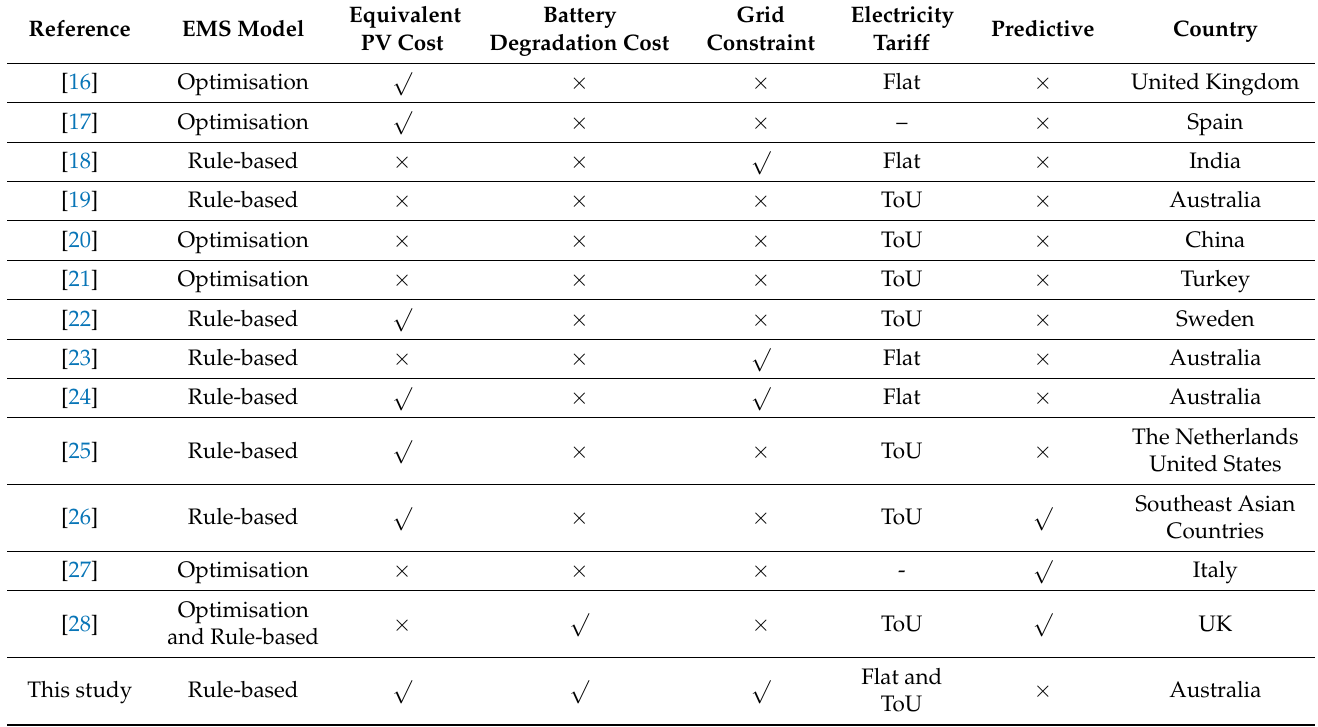
Table 1. Summary of drawbacks of the existing